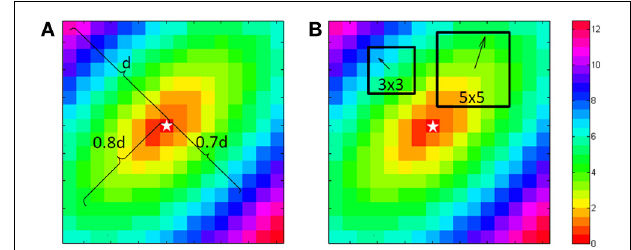
FIGURE 2 | Data from dog experiment. (A) Are the measured activation times. (B) The vector field derived from the activation times in panel a by using a 3 by 3 neighborhood least square fit. (C) Shows the approximately ellipsoid isochrones at 2ms distance. The black arrow is used for the